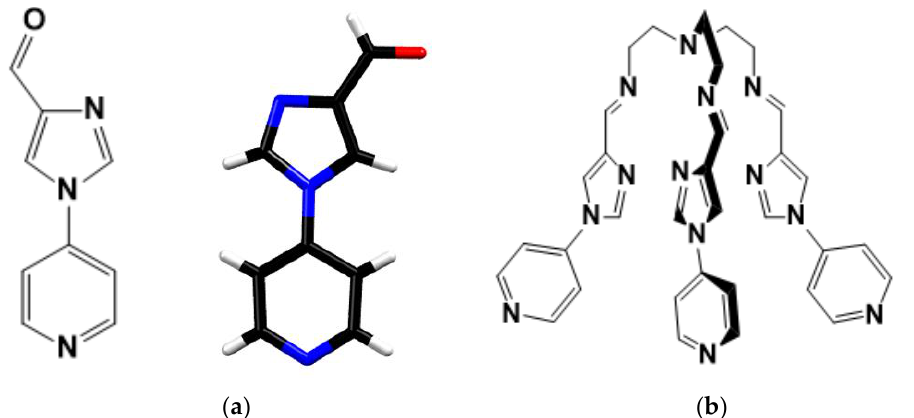
Figure 1. ( a ) Molecular structure of the precursor with its crystal structure, Colour codes: C-Black, N-blue, O-Red, H-White ( b ) Molecular structure of tripodal ligand 2.